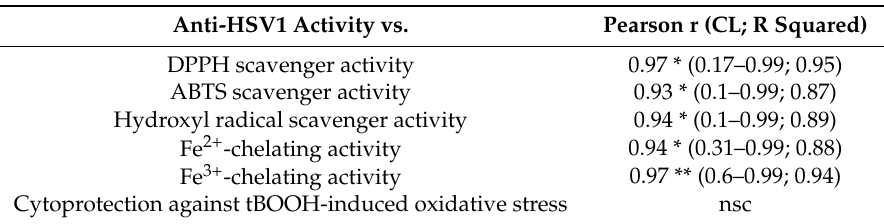
Table 7. Pearson correlation coefficient among antioxidant activity, cytoprotection against oxidative stress and antiviral activity for DR2C